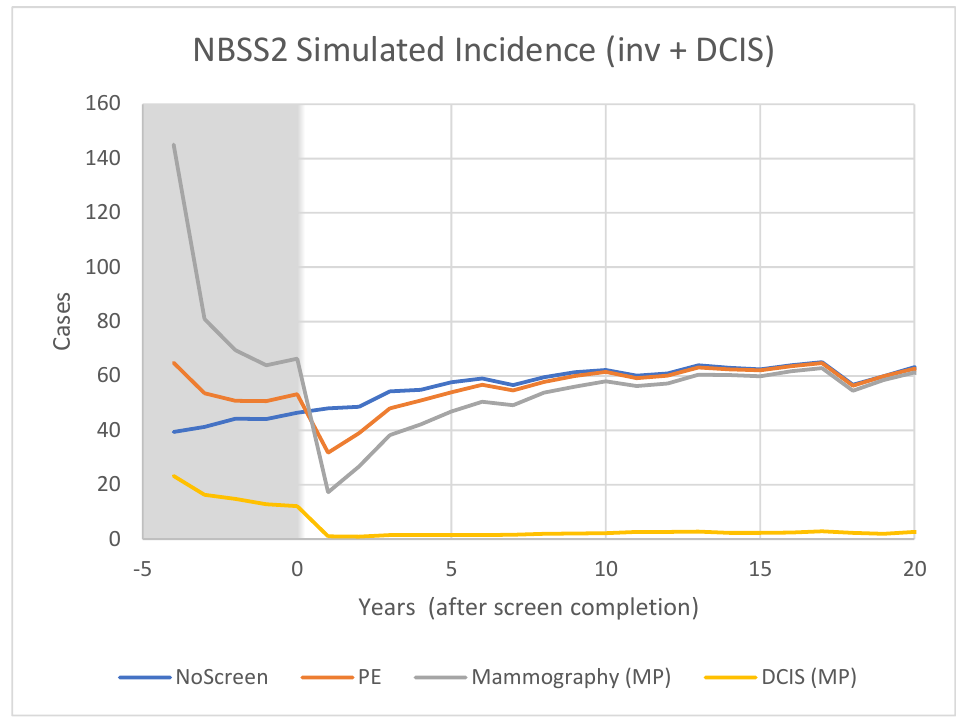
Figure 6. Predicted incidence of breast cancer (OncoSim-Breast model) for women who are un- screened and in the Mammography or Physical Examination arms of the CNBSS2 trial.